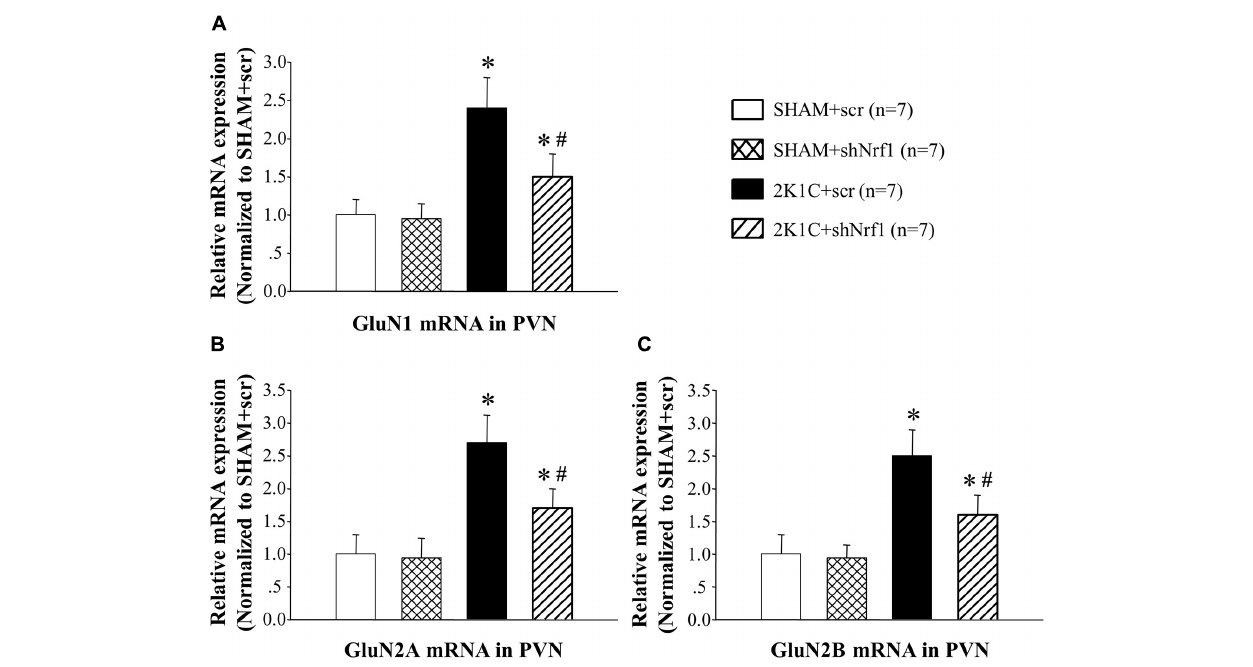
FIGURE 8 | Effects of knocking down of Nrf1 on GluN1, GluN2A, and GluN2B mRNA expression in PVN of hypertensive rats by real-time PCR. (A) Group data for GluN1 mRNA expression in PVN; (B) group data for GluN2A mRNA in PVN; (C) group data for GluN2B mRNA in PVN. ∗ P < 0.05 vs. control animals (SHAM + scr or SHAM + shNrf1). # P < 0.05 2K1C + shNrf1 vs. 2K1C +